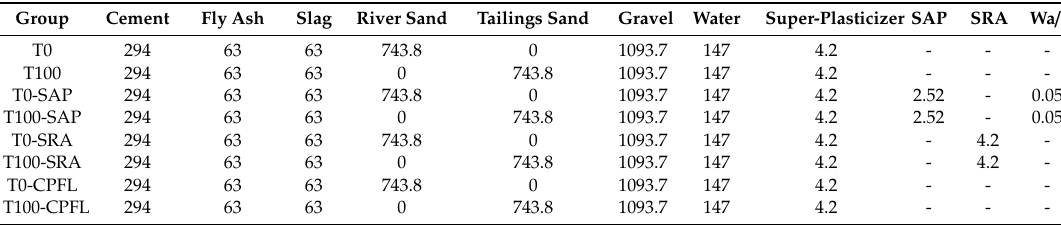
Table 4. Mix proportion of iron tailings sand concrete (kg/m 3 ).